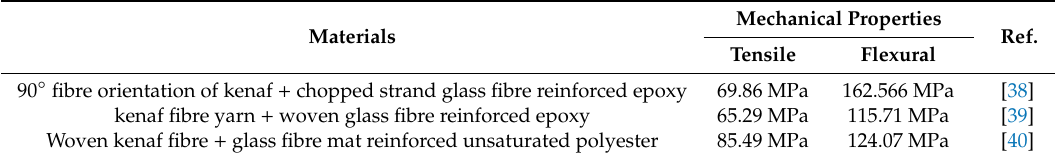
Table 4. Reported research on mechanical properties of kenaf / glass fibre hybrid